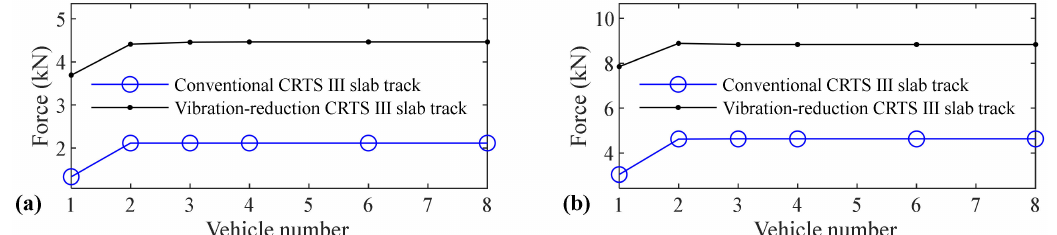
Figure 12. Relation between vehicle number and tension force of fastener: ( a ) without and ( b ) with random track